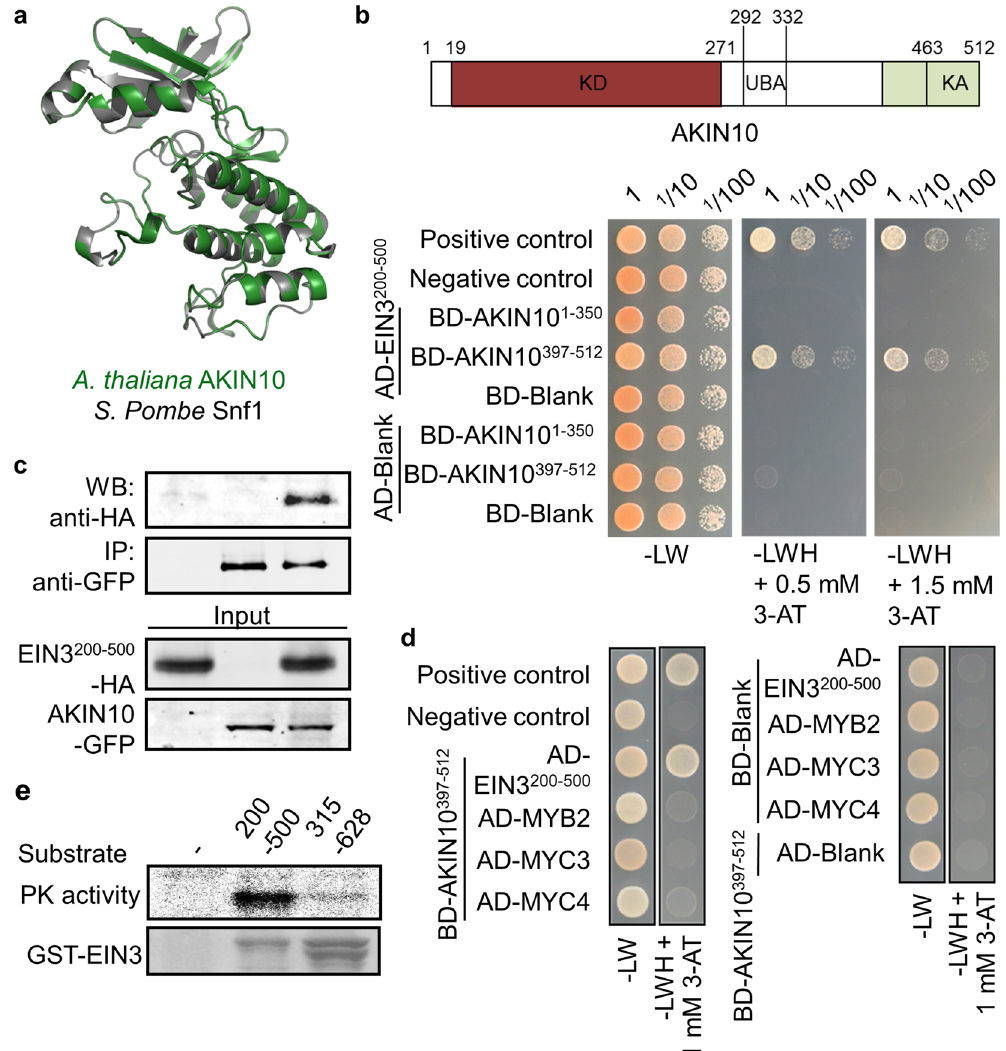
Figure 1. AKIN10 interacts directly with EIN3. ( a ) Structure modeling of protein kinase domain of Snf1 in S . pombe and AKIN10 in A . thaliana . Individual protein structures were generated using SWISS-MODEL (http:// swissmodel.expasy.org) and visualized in a superimposed image using PyMOL (http://www.pymol.org). ( b ) Binary protein-protein interaction of AKIN10 and EIN3 was analyzed using a yeast two-hybrid system. ( c ) Protein-protein interaction of AKIN10 and EIN3 was confirmed by co-immunoprecipitation using Arabidopsis protoplasts transfected with a combination of AKIN10 and EIN3 constructs. ( d ) Binary protein-protein interactions between AKIN10 with MYB2, MYC3, or MYC4 were analyzed using a yeast two-hybrid system. ( e ) AKIN10-dependent EIN3 phosphorylation in vitro was shown with GST-EIN3 fragments as substrate. Coomassie blue staining was used for protein substrate visualization. All experiments were repeated with consistent